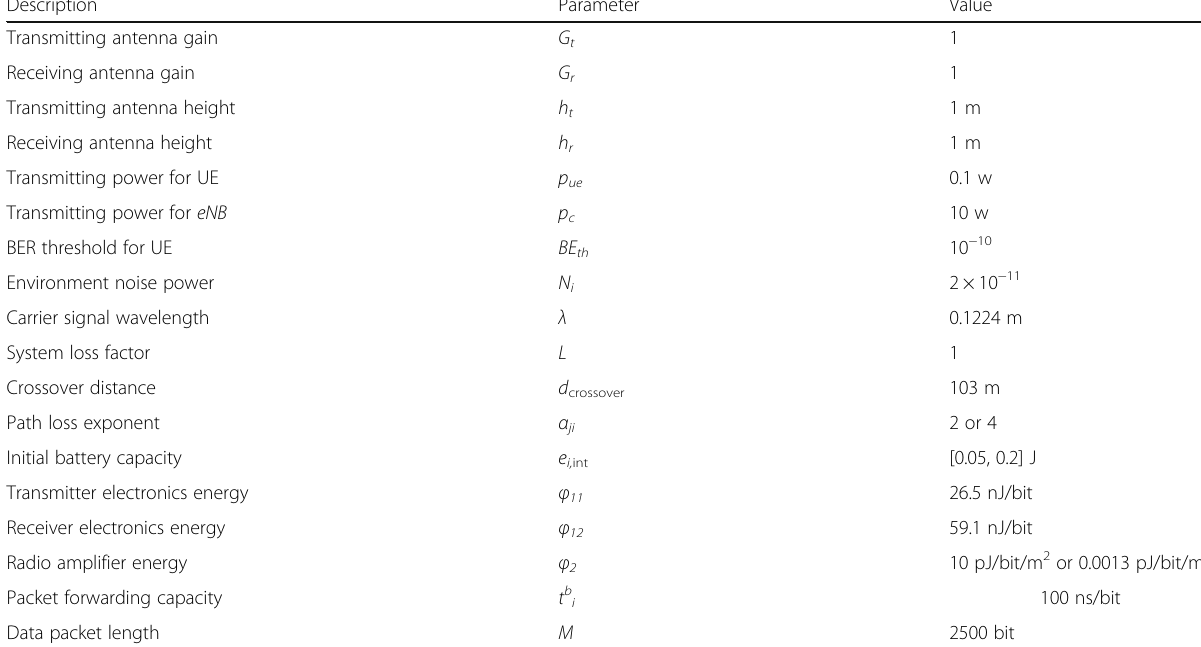
Table 3 Simulation